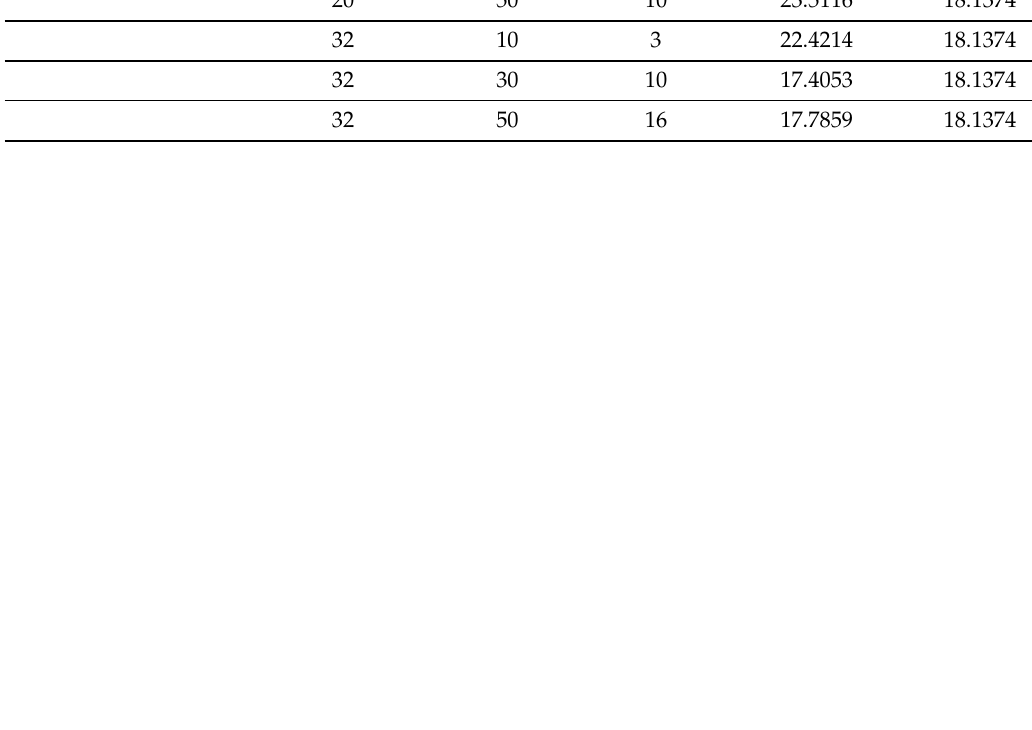
Table A10. DTW values for LT _ Vid . mp 4 with image size of 320 × 240; C ∗ and C ∗ is Human Count (ground truth). 3 Img.